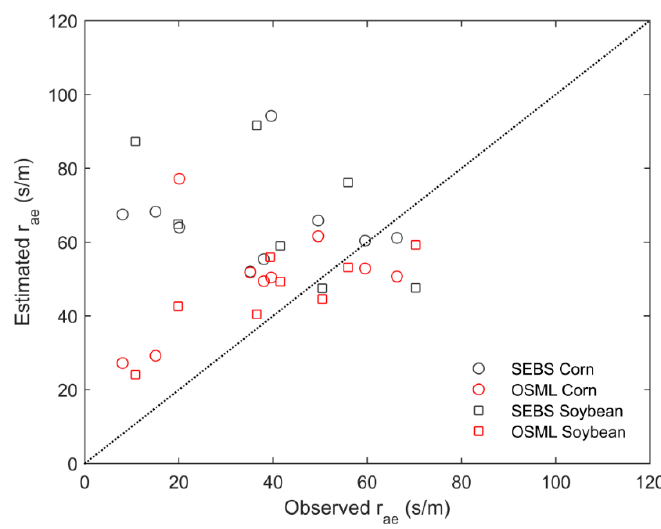
Figure 10. Evaluation of r ae_OSML and r ae_SEBS against r ae_obs .